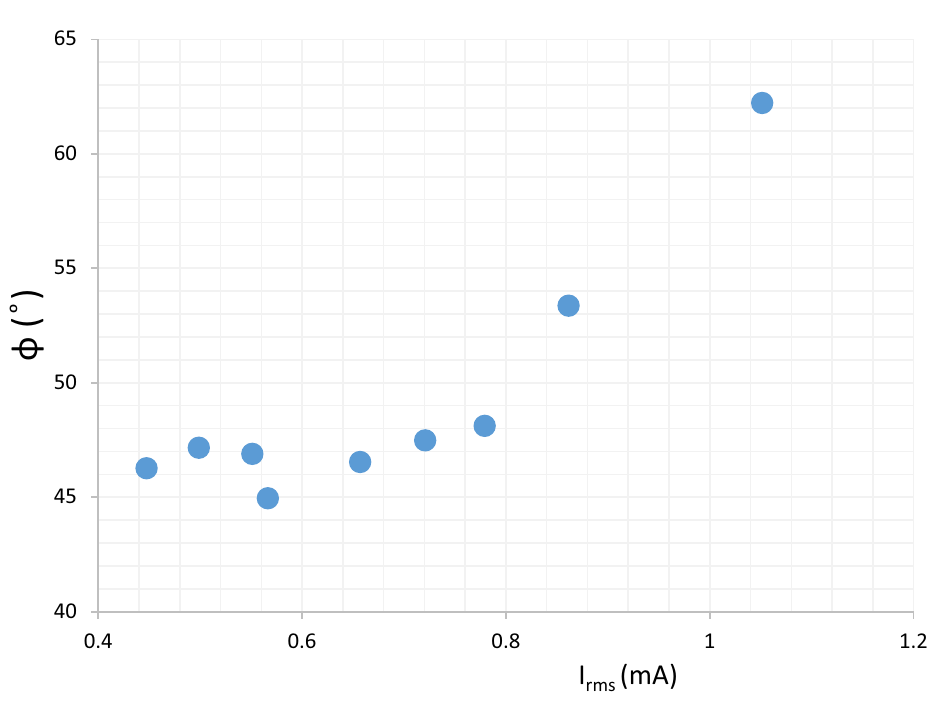
Figure 10. Phase angle representing capacitive nature of JDBD